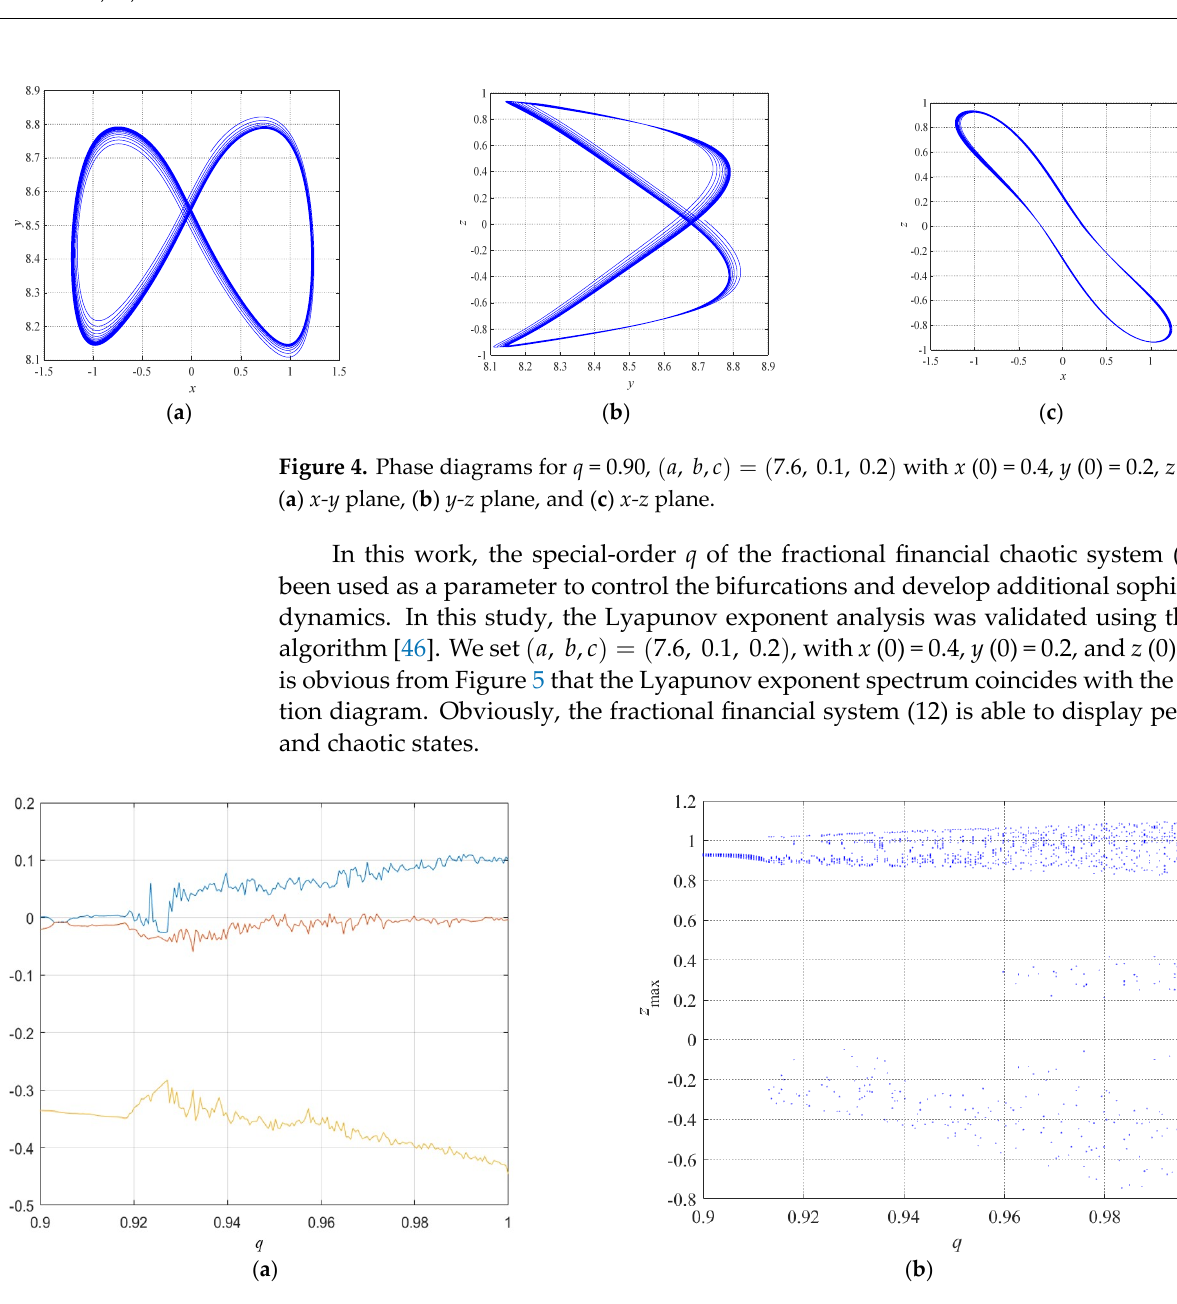
Figure 5. MATLAB simulation for financial fractional-order chaotic system: ( a ) Lyapuov exponent for q [0.9 1] and ( b ) bifurcation diagram for q [0.9 1].